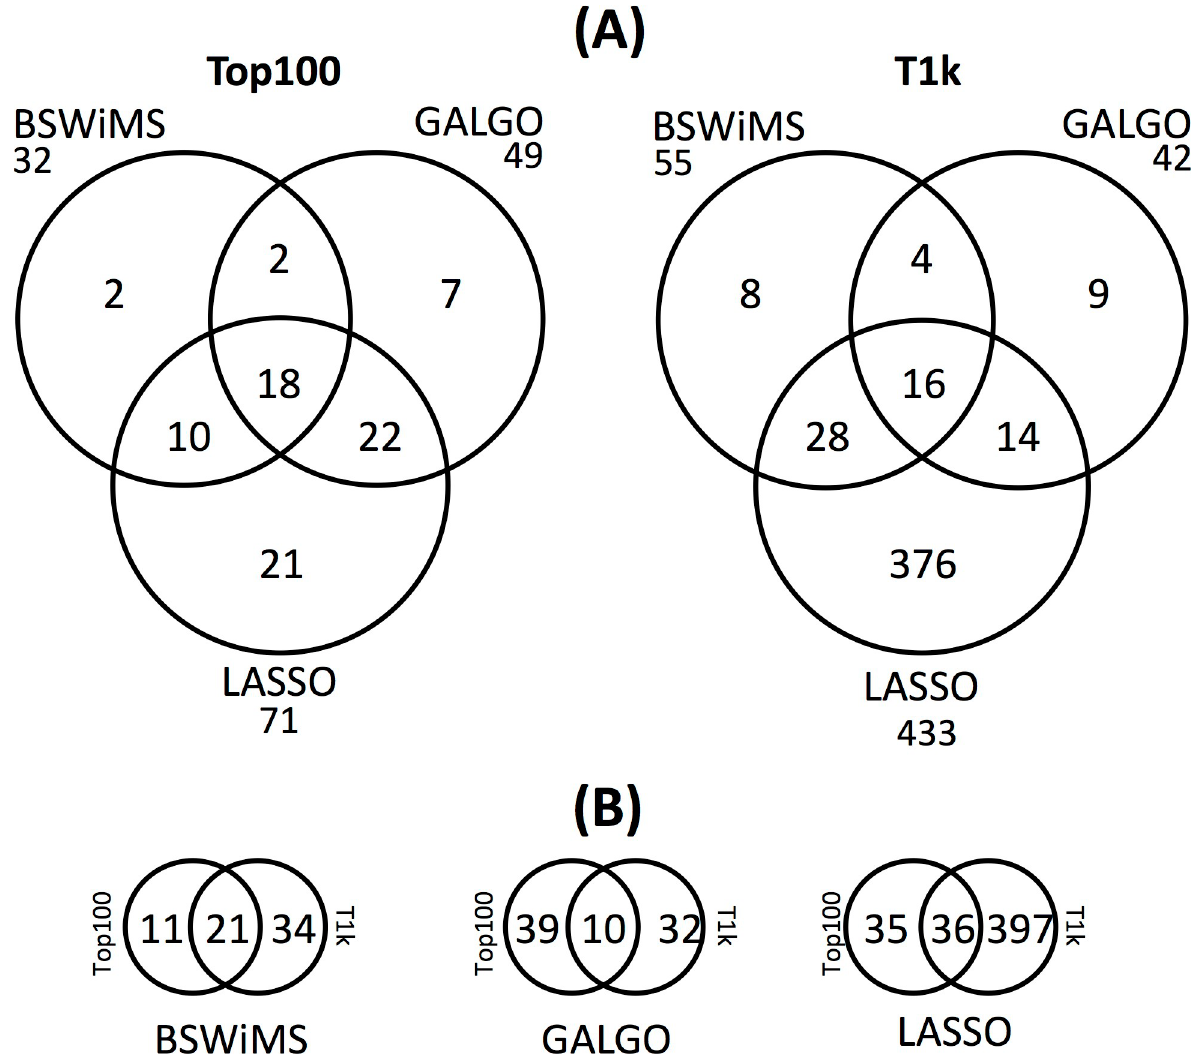
Fig 4. Comparison of the SNPs obtained from the three ML methods. Details are shown in supplementary